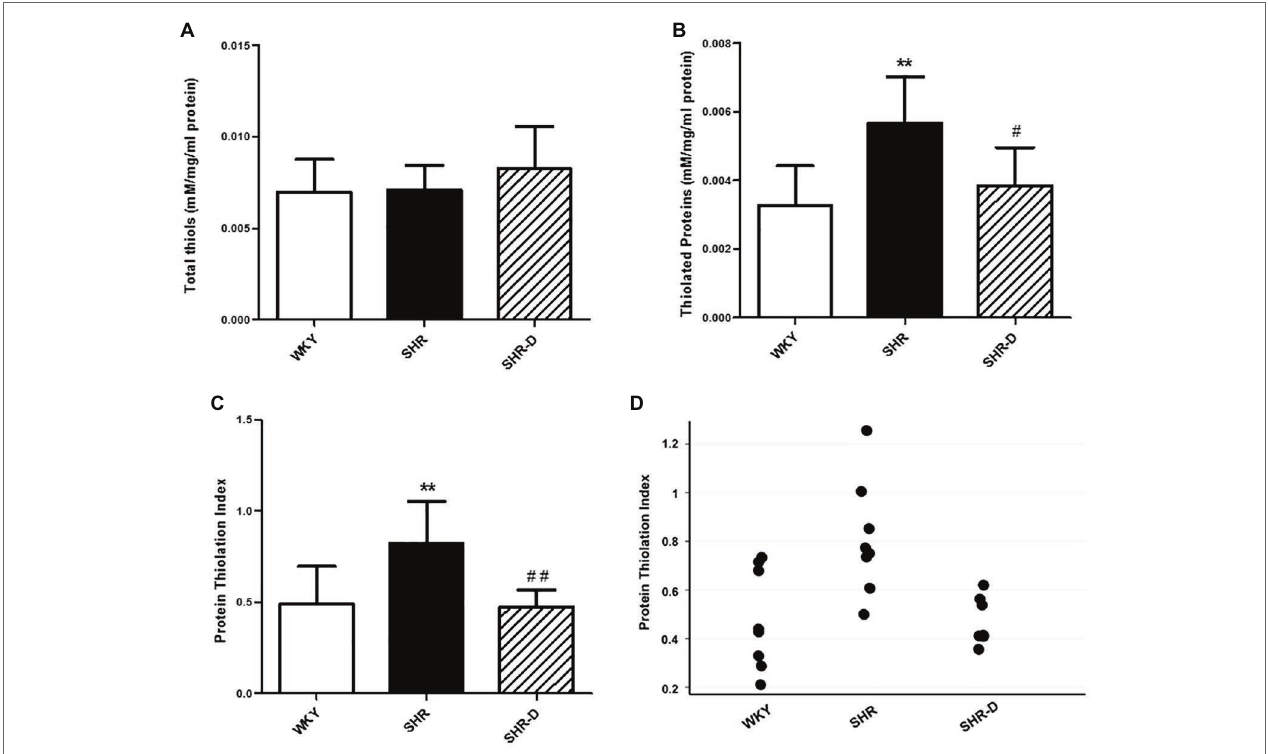
FIGURE 4 | Thiol-specific oxidative stress analysis. (A) Plasma concentration of thiols, (B) thiolated proteins, (C) protein thiolation index (PTI), and (D) data points of the protein thiolation index from WKY treated with vehicle, SHR treated with vehicle, and SHR-D treated with dronedarone. Statistically significant differences among WKY, SHR, and SHR-D are shown (** p < 0.01 vs. WKY; # p < 0.05 vs. SHR; and ## p < 0.01 vs. SHR). Values are shown as mean ± SEM ( n = 8 per